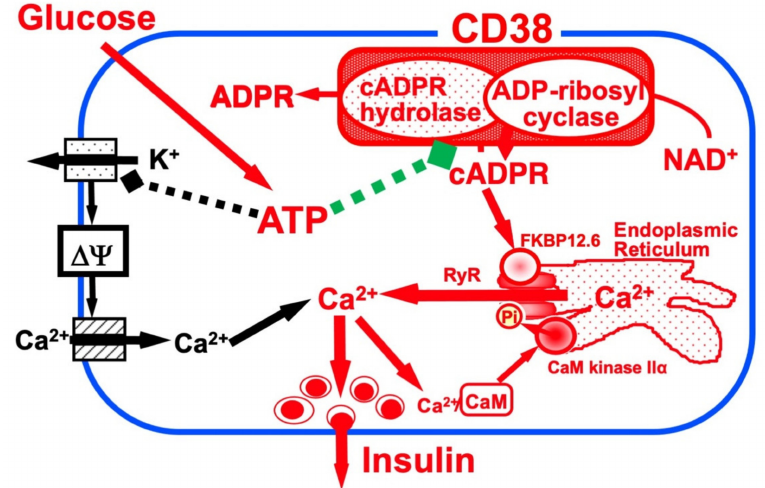
Figure 1. Insulin secretion by glucose stimulation in pancreatic β -cells (adapted from [33]). The insulin secretion via the CD38-cADPR signal system is shown in red. cADPR, produced from NAD + by the ADP-ribosyl cyclase of CD38, binds to FKBP12.6 to release Ca 2+ , dissociating FKBP12.6 from RyR [25]. CaM kinase II phosphorylates RyR to sensitize and activate the Ca 2+ channel (Pi, phosphorylation of RyR by CaM kinase II) [24]. Ca 2+ , released from intracellular stores and/or supplied from extracellular sources, further activates CaM kinase II and amplifies the process. In this way, Ca 2+ -induced Ca 2+ release (CICR) can be explained in glucose-induced insulin secretion in pancreatic β -cells. The conventional insulin secretion mechanism by Ca 2+ influx from extracellular sources [16] is shown in